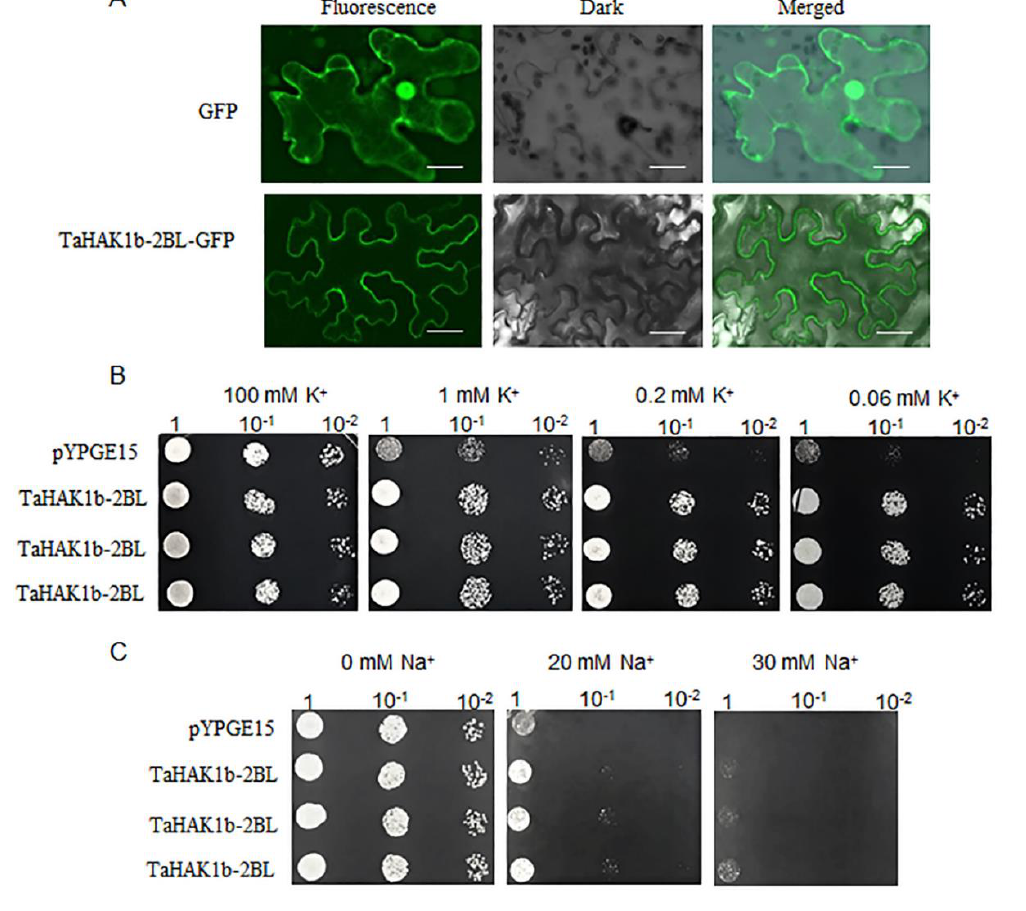
Figure 8. Subcellular location of TaHAK1b-2BL and its roles in potassium uptake and salt tolerance. ( A) . Subcellular location of TaHAK1b-2BL . Scale bars = 20 µm. ( B ). Functional complementary assay of TaHAK1b-2BL in a high-affinity potassium uptake deficient yeast mutant. Yeasts transformed with the empty vector (pYPGE15) were used as a negative control. The tested potassium concentrations were indicated above each panel. Serial dilutions (10 − 1 ) of yeast culture were plated. ( C ). Salt tolerance assay of TaHAK1b-2BL . The tested sodium concentrations were indicated above each panel. Serial dilutions (10 − 1 ) of yeast culture were plated.